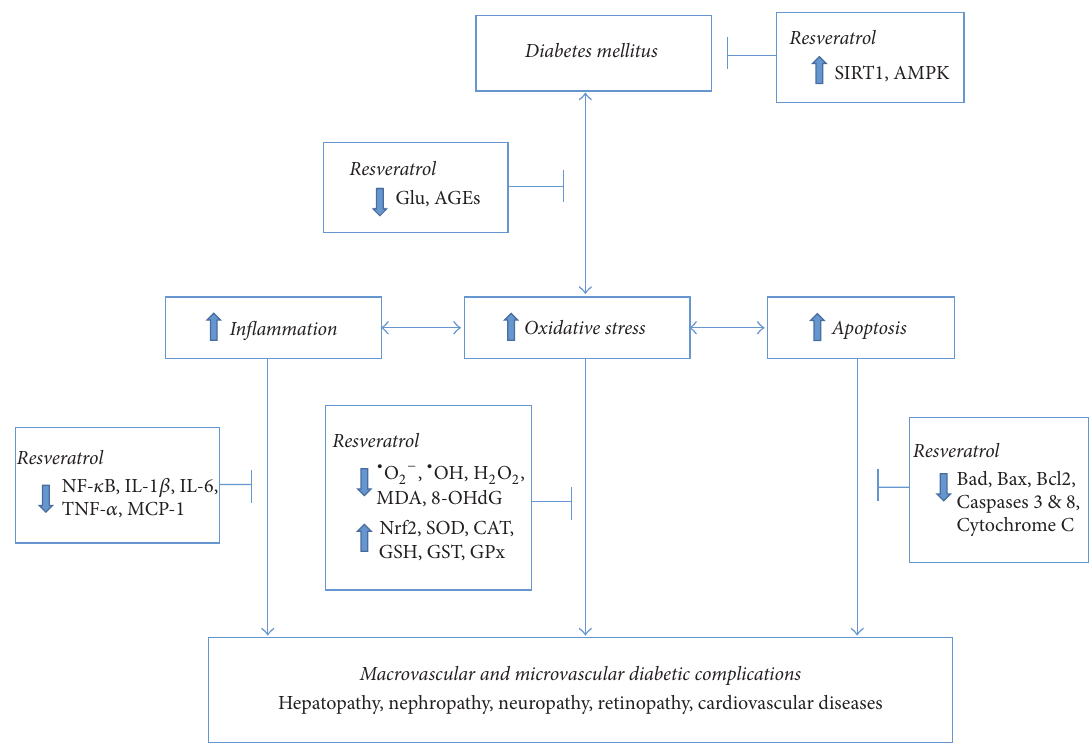
Figure 3: A simplified scheme showing mechanisms of resveratrol protection against the development of diabetic complications. SIRT1, sirtuin-1; AMPK, adenosine monophosphate activated kinase; Glu, glucose; AGEs, advanced glucose end-products; ∙ O anion; ∙ OH, Hydroxide radical; H 2 O 2 , hydrogen peroxide; MDA, malondialdehyde; 8-OHdG, 8-hydroxydeoxyguanine; Nrf2, nuclear factor erythroid 2-related factor 2; SOD, superoxide dismutase; CAT, catalase; GSH, reduced glutathione; GST, glutathione S-transferase; GPx, glutathione peroxidase; NF- 𝜅 B, nuclear factor-kappa B; IL, interleukin; TNF, tumour necrosis factor; MCP, monocyte chemoattractant protein; Bcl2, B-cell lymphoma 2; Bad, Bcl-2-associated death promoter; Bax, bcl-2-like protein